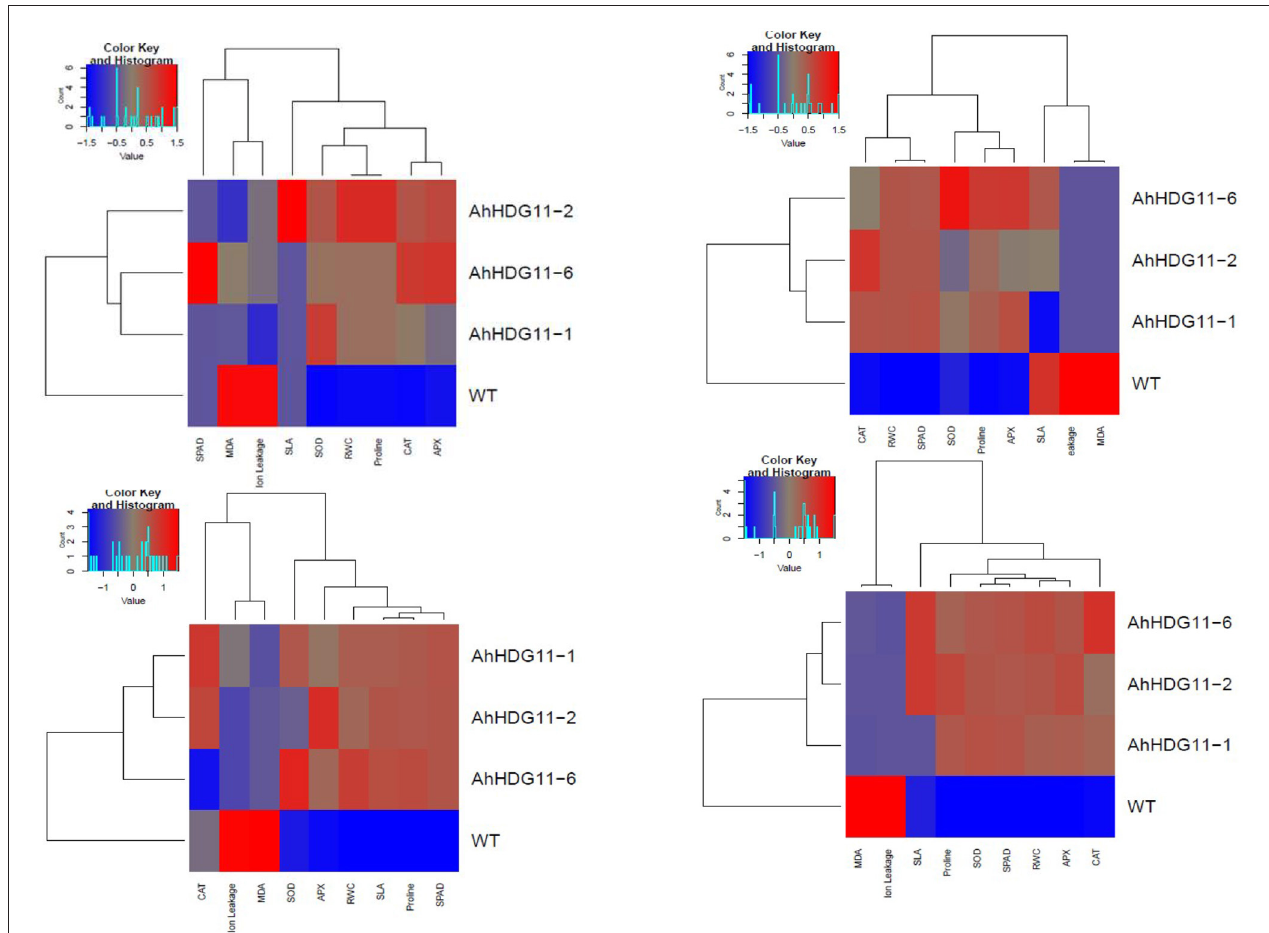
FIGURE 11 | Overall assessments of physiological and biochemical responses in non-transgenic and transgenic lines during well-water (A) , drought stress (B) , re-watering (C) , and salt stress (D) . The relative values of physiological, biochemical parameters for the heat-map analysis. Scale: for the drought and salt tolerance capabilities, from brightest blue equal lowest to brightest red equal highest capabilities; for physiological and biochemical parameters, from brightest blue equals most decreased to brightest red equals most